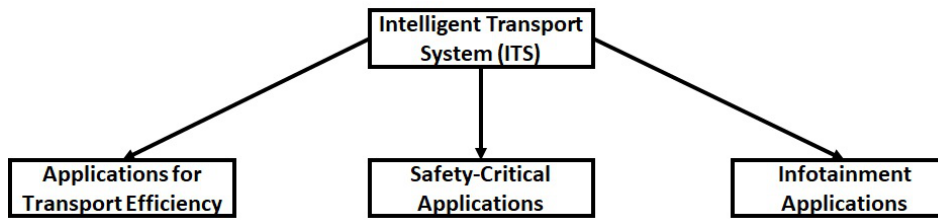
Figure 1. Different applications for intelligent transport system (ITS).